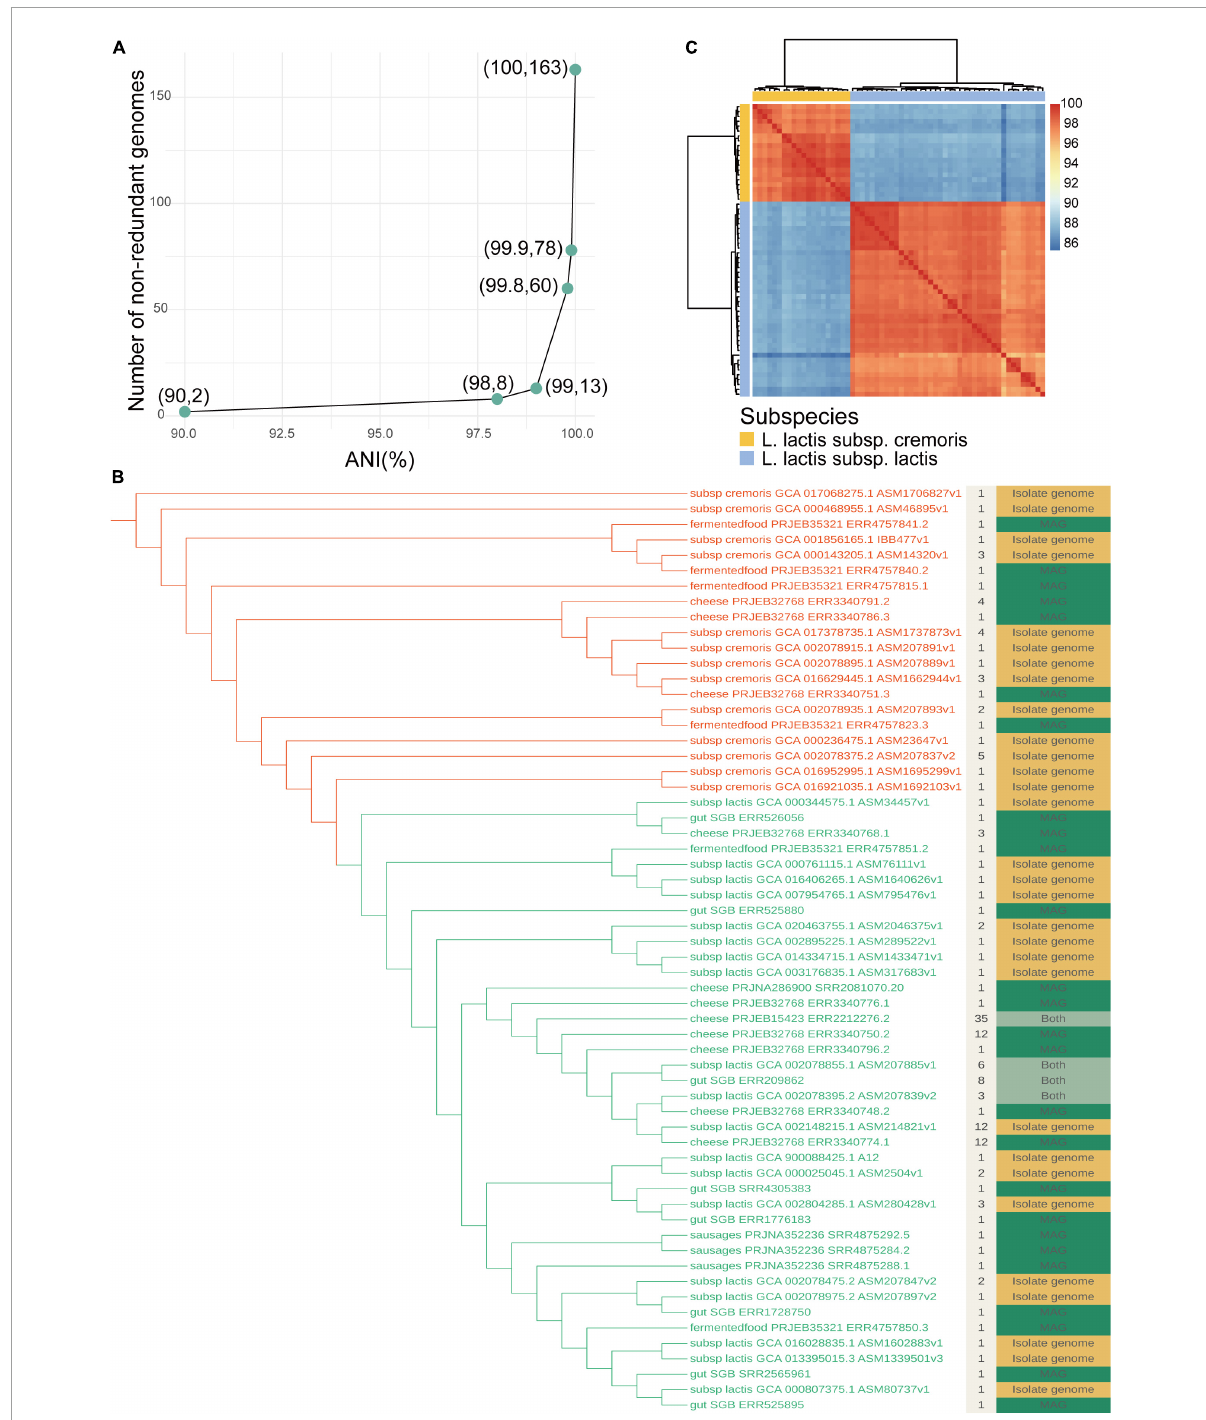
FIGURE4 Intraspecies diversity of Lactococcus lactis . (A) The number of non-redundant genomes with different ANI. ANIs of 90%, 98%, 99%, 99.8%, 99.9%, and 100% were used to remove redundancy. (B) Maximum-likelihood phylogenetic tree of non-redundant genomes belonging to L. lactis . The tree showing all 60 dereplicated genomes was computed using a core gene alignment file generated from pangenome analysis, bootstrapped *1000 replicates. The colors of branches distinguish subclades: L. lactis subsp. cremoris (marked in red) and L. lactis subsp. lactis (marked in green). The layer beside the tree displays the number of genomes included in each clustering group. The outmost layer is colored according to whether the strain of each group has been cultured, where green represents that all genomes are in a culturable state, yellow represents that all genomes are uncultured and the light green represents that both states are present. (C) Similarity heatmap of all non-redundant genomes. Each row (and column) represents a genome and the fill value shows the ANI between each pair. The yellow strip marks genomes belonging to L. lactis subsp. cremoris and blue marked L. lactis subsp.